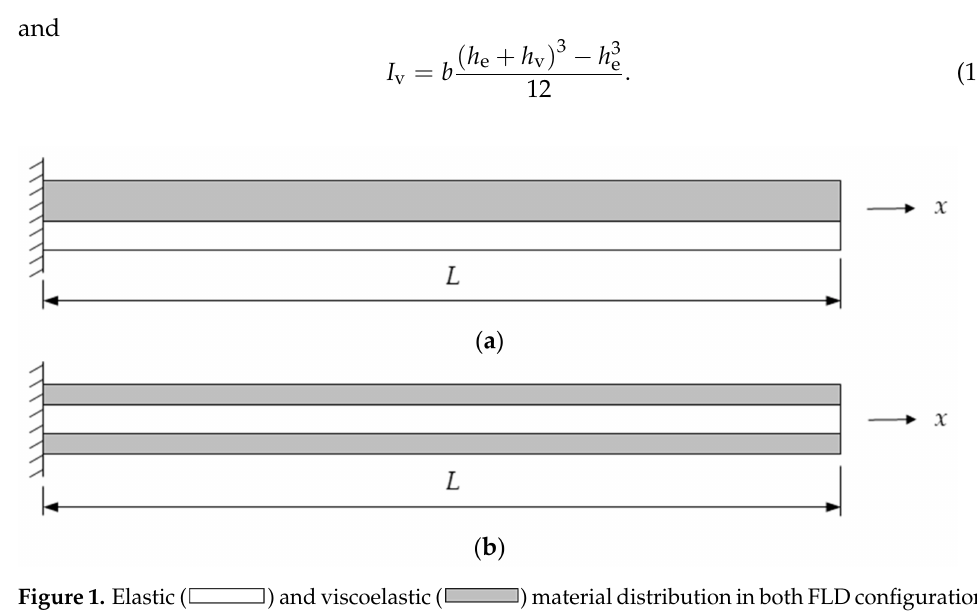
( ) material distribution in both FLD configurations: ( a ) Asymmetrical configuration; ( b ) Figure 1. Elastic ( Figure 1. Elastic ( ) and viscoelastic ) and viscoelastic ( Symmetrical